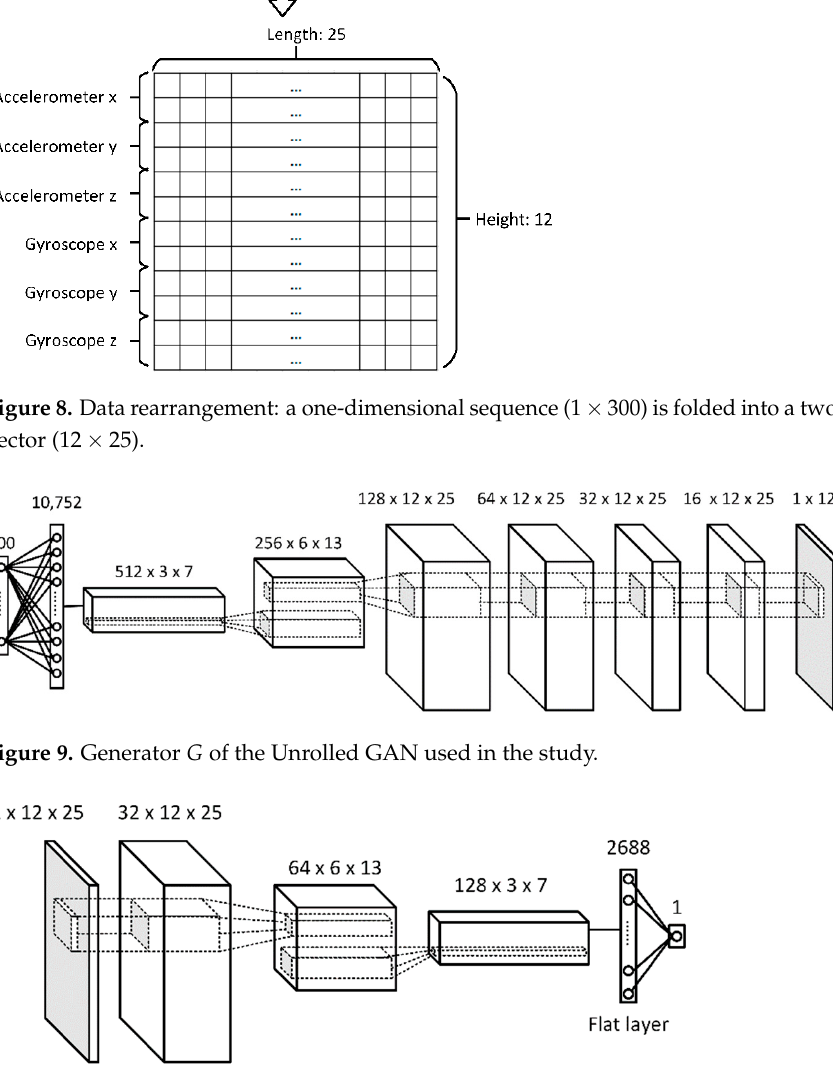
Figure 9. Generator (cid:1833) of the Unrolled GAN used in the study.